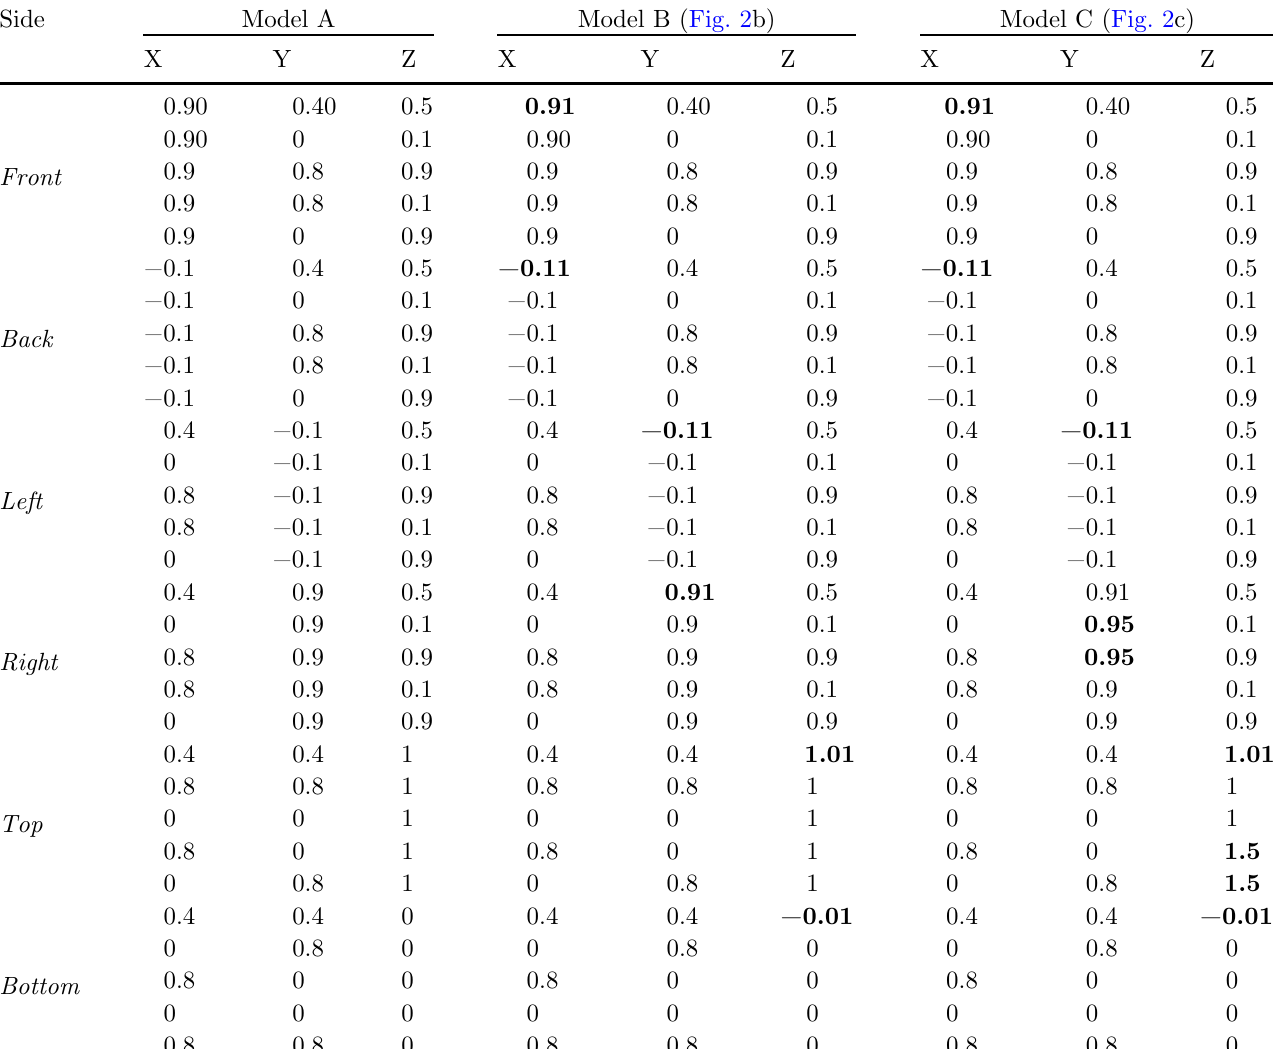
Table 1. The coordinates of points for the theoretical models (in normalized units).